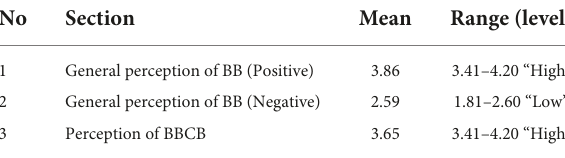
TABLE 3 Overall descriptive statistics of student